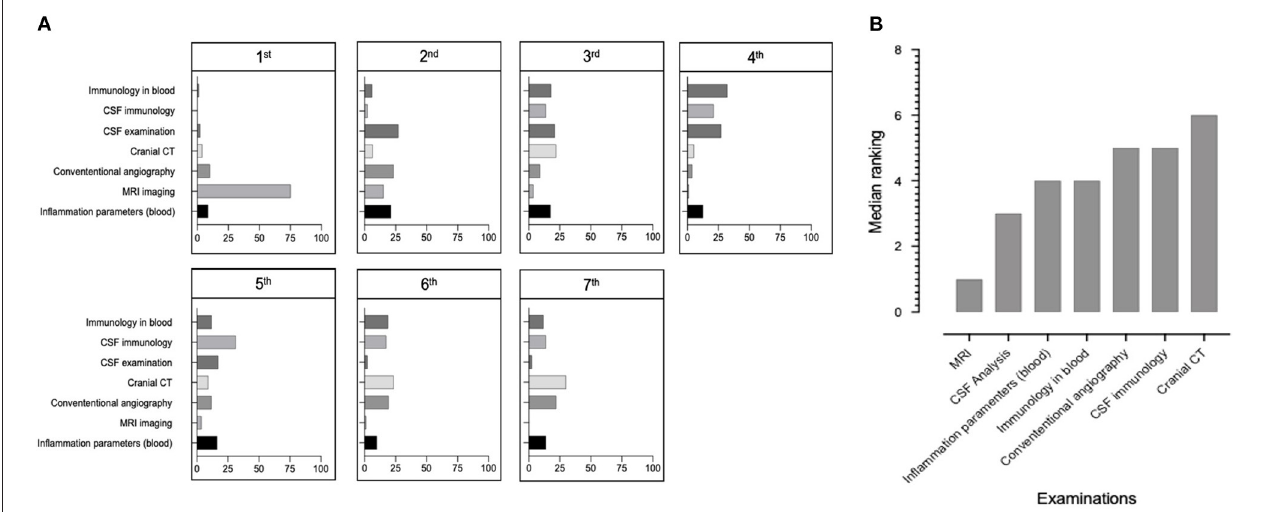
FIGURE 2 | Importance of diagnostic tools. (A) Bar chart data illustrating the percentage of respondents who indicated which diagnostic tests they thought was more important. Respondents were asked to rank the following examinations according to their importance for the diagnosis of p-cPACNS from 1 being the most important and 7 being the least important ( n = 86). (B) Bar chart using median data illustrating which diagnostic tests respondents ranked as most important (1) and least importance (7). ( n =